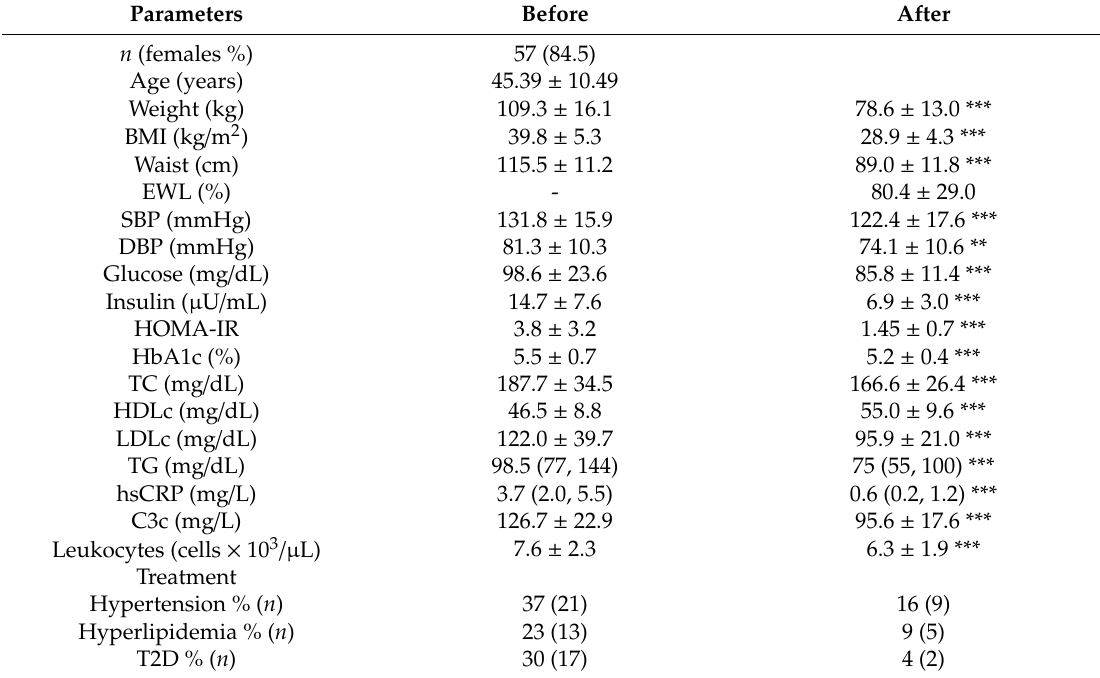
Data are expressed as the mean ± SD or percentage ( n ). TG and hsCRP are represented as the median and IQ range (25% and 75% percentile). Values were statistically compared with a paired Student’s t -test or Wilcoxon test and were considered significant when ** p < 0.01, and *** p < 0.001. BMI: Body mass index; EWL: Excess weight loss; SBP: Systolic blood pressure; DBP: Diastolic blood pressure; HOMA-IR: Homeostatic Model Assessment